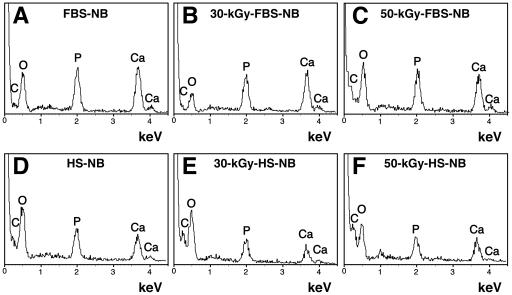
NB cultured from either untreated serum or γ-irradiated serum show similar elemental compositions when analyzed by energy-dispersive X-ray spectroscopy.NB were retrieved from the experiments described in Figure 6. Precipitates were taken from 2-month-old cultures of either untreated FBS (A) or from FBS γ-irradiated at either 30 kGy (B) or 50 kGy (C). In (D–F), NB specimens were obtained from cultures of untreated HS (D) or from HS γ-irradiated at either 30 kGy (E) or 50 kGy (F). Following centrifugation and washing, the specimens were processed for EDX as described in the
Materials and Methods
. Major peaks of carbon (C), oxygen (O), phosphorus (P), and calcium (Ca) were noticed for the various NB specimens, consistent with the presence of a calcium phosphate mineral containing carbonate ions. The following Ca/P ratios were obtained: (A) 1.40; (B) 1.40; (C) 1.24; (D) 0.98; (E) 0.86; and (F) 1.09.